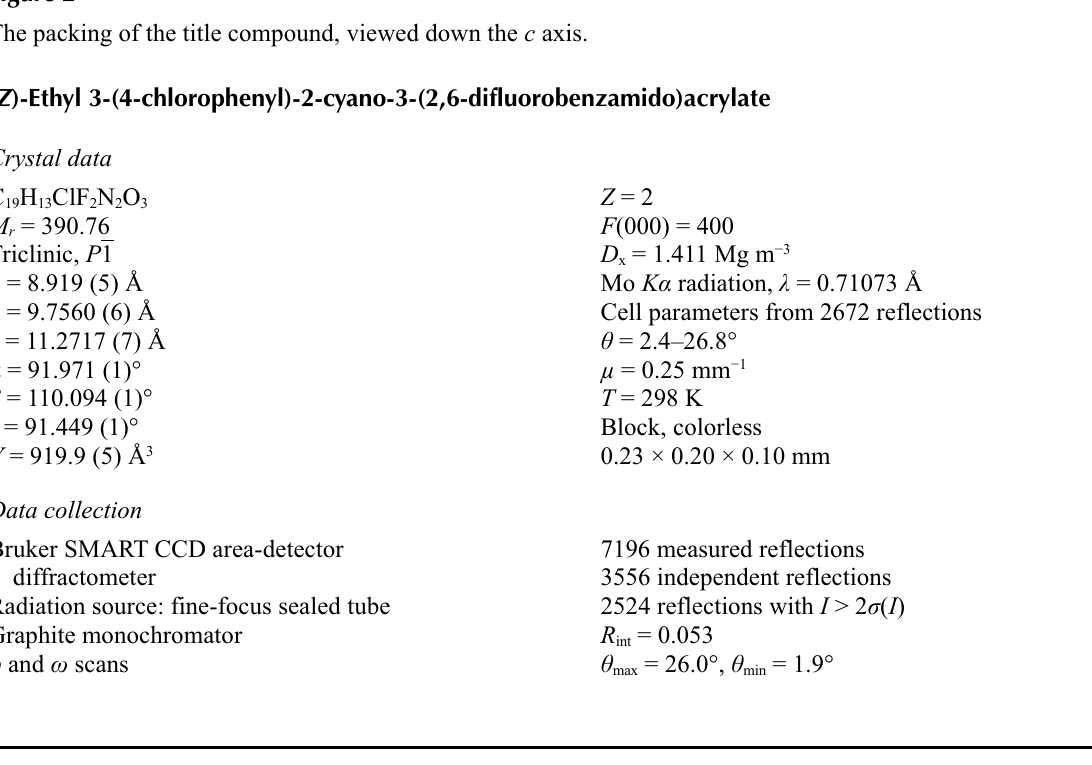
The packing of the title compound, viewed down the c